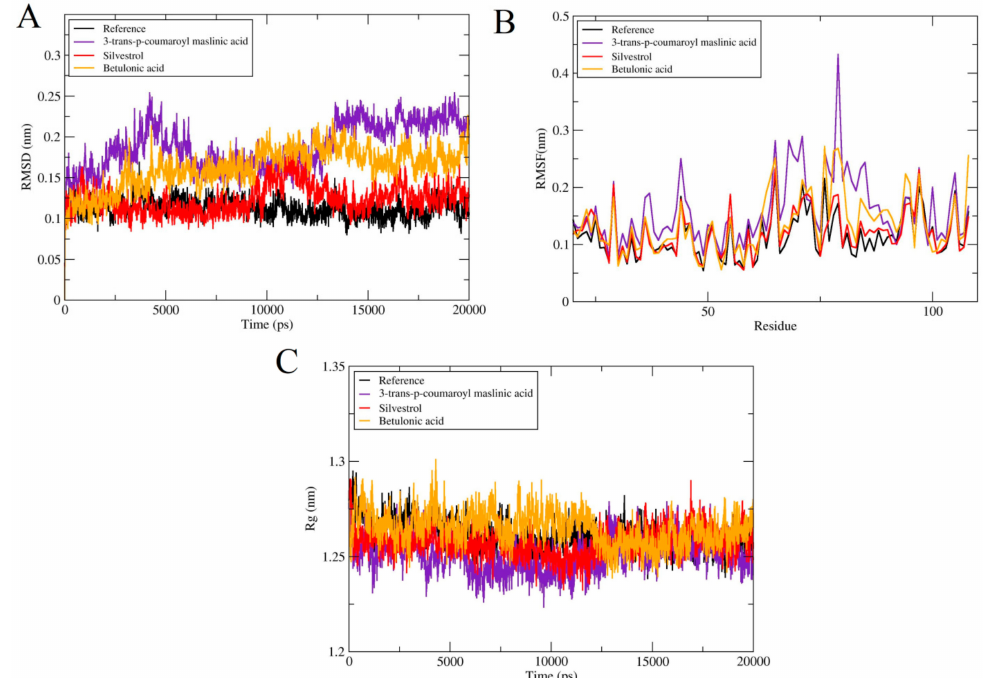
Figure 3. Comparison and detail representation of ( A ) RMSD: Root mean square deviations, ( B ) RMSF: Root mean square fluctuations and ( C ) Potential energy over the time of 20 ns of Reference and all terpenes